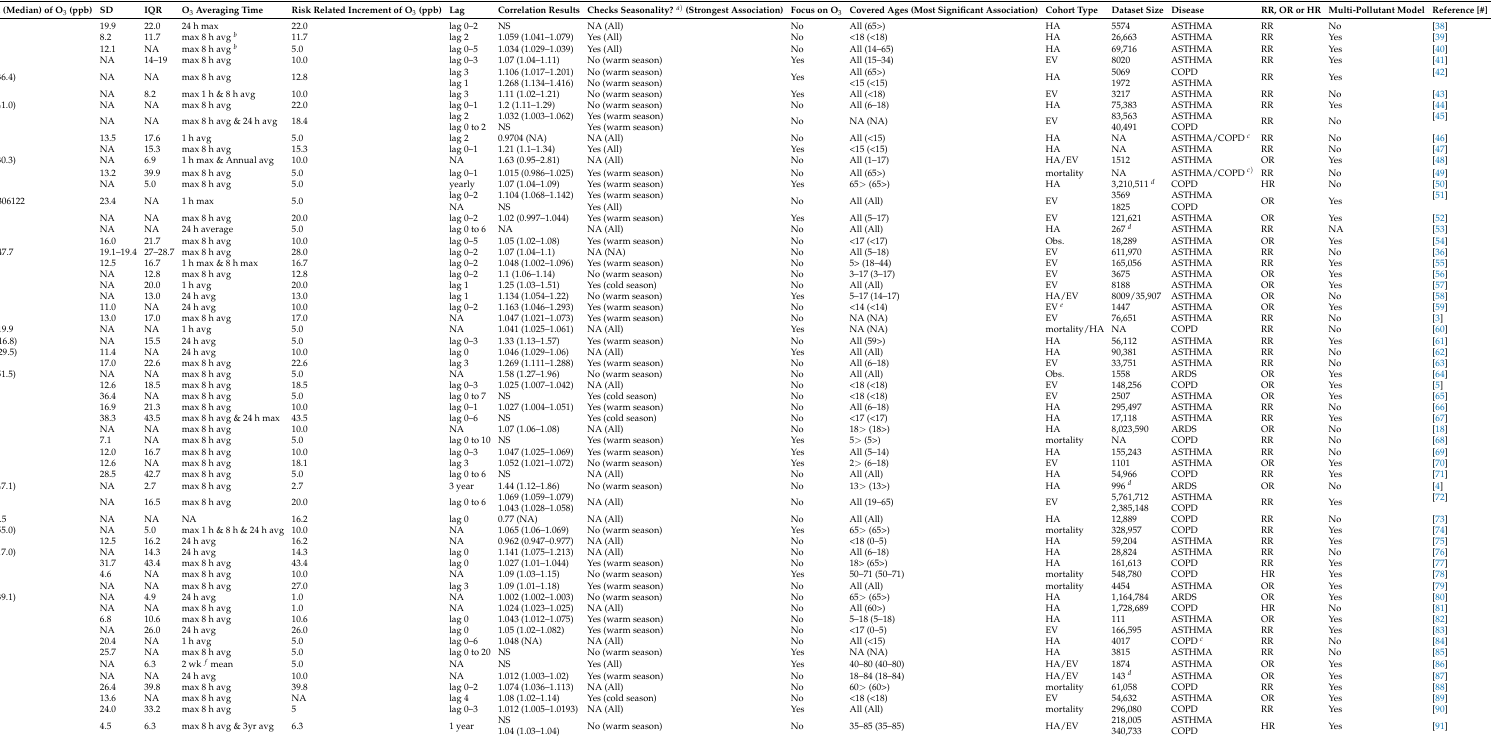
Table 2. All studies analysed in this